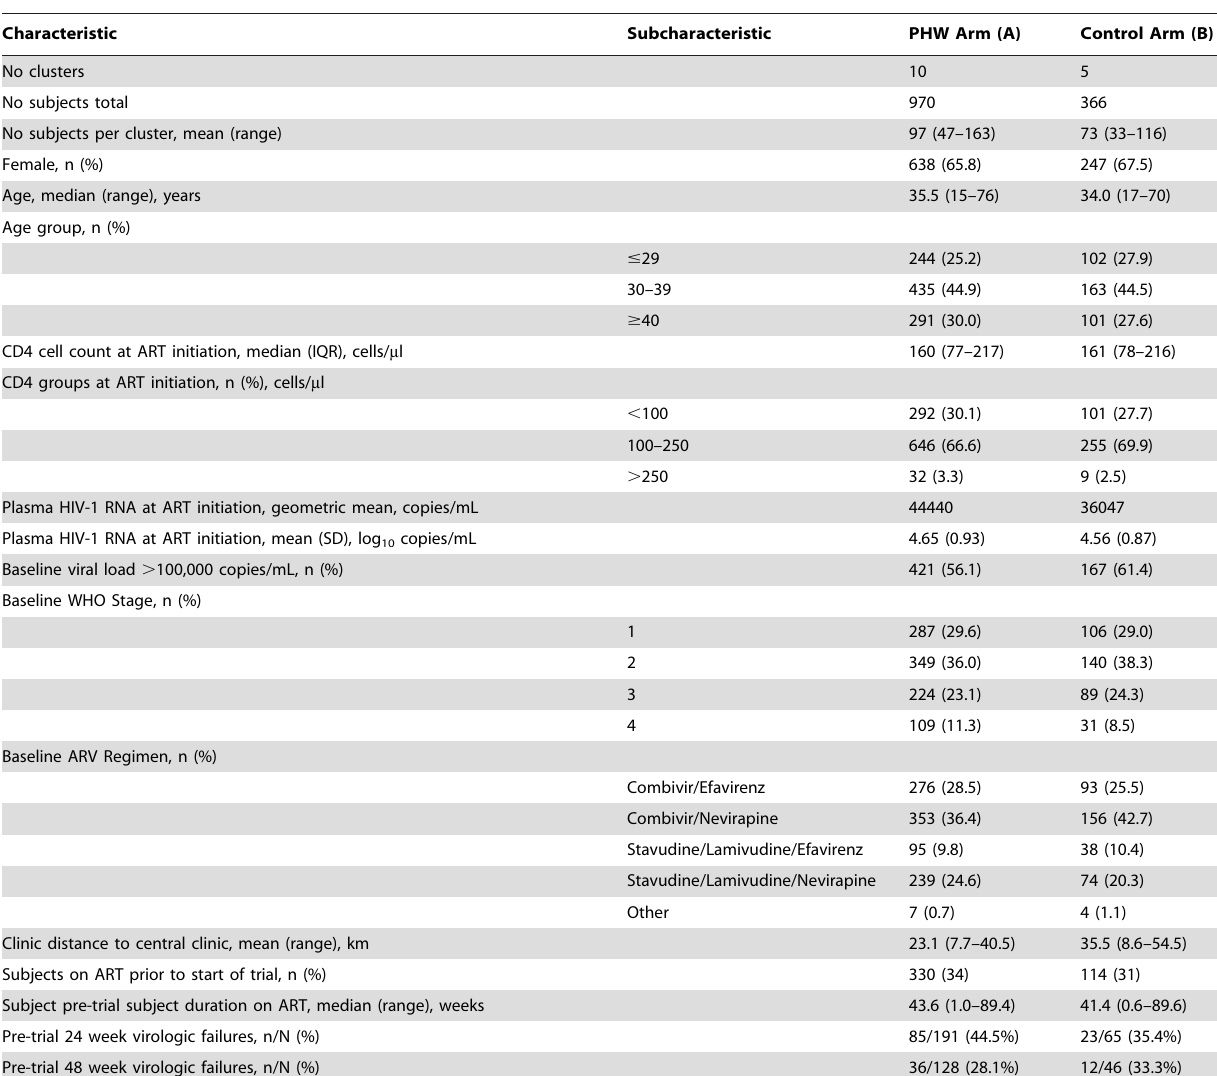
Table 1. Characteristics according to randomization